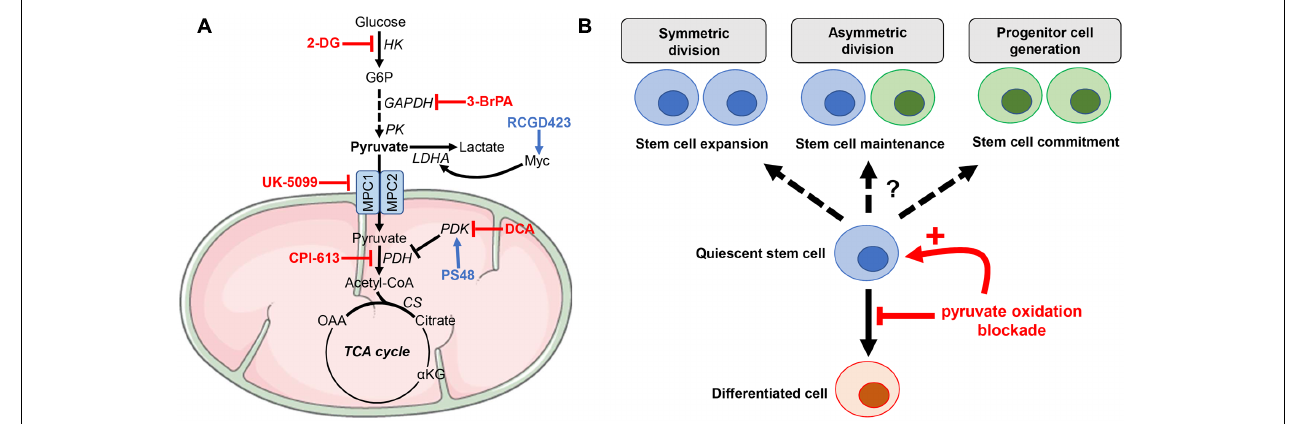
FIGURE 2 | Manipulating pyruvate metabolism in stem cells. (A) Small molecules targeting either reductive or oxidative metabolism of pyruvate can be used to rewire stem cell metabolism. (B) Blockade of pyruvate oxidative metabolism may impair cell differentiation while promoting stem cell activation toward either expansion, maintenance or commitment. 2-DG, 2-deoxyglucose; 3-BrPA, 3-bromopyruvate; DCA,